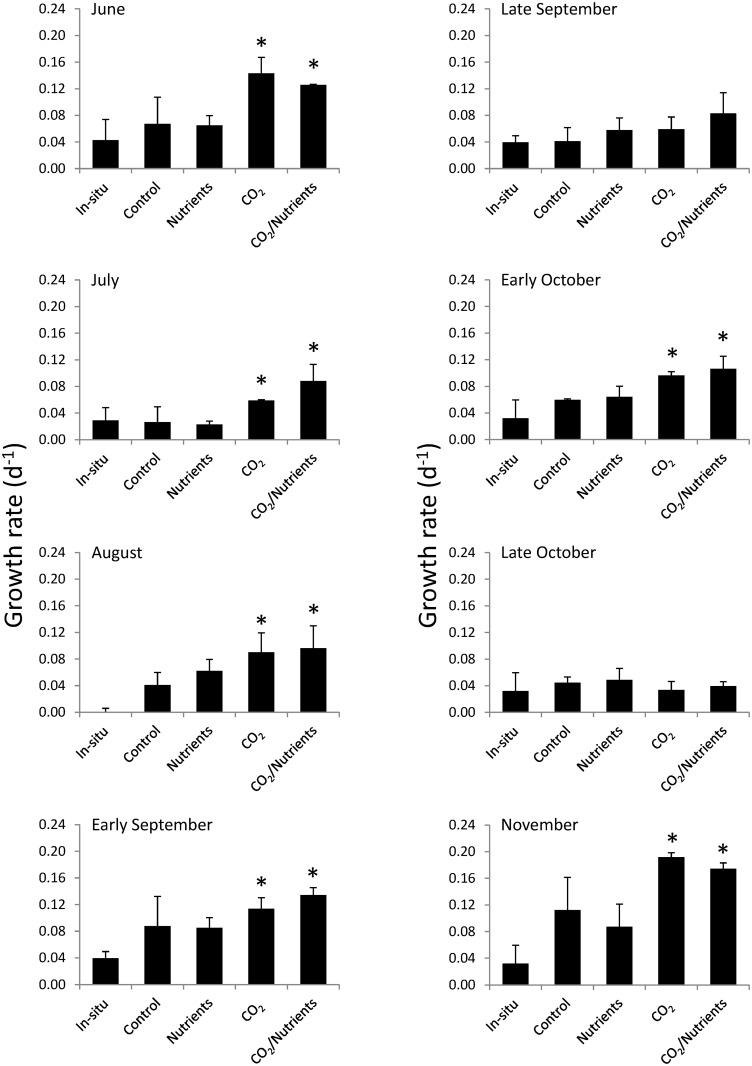
Gracilaria growth rates.Growth rates of Gracilaria exposed ambient and elevated CO2 conditions with and without nutrient additions for experiments performed August through November. Columns with an asterisk over them indicate significant results.